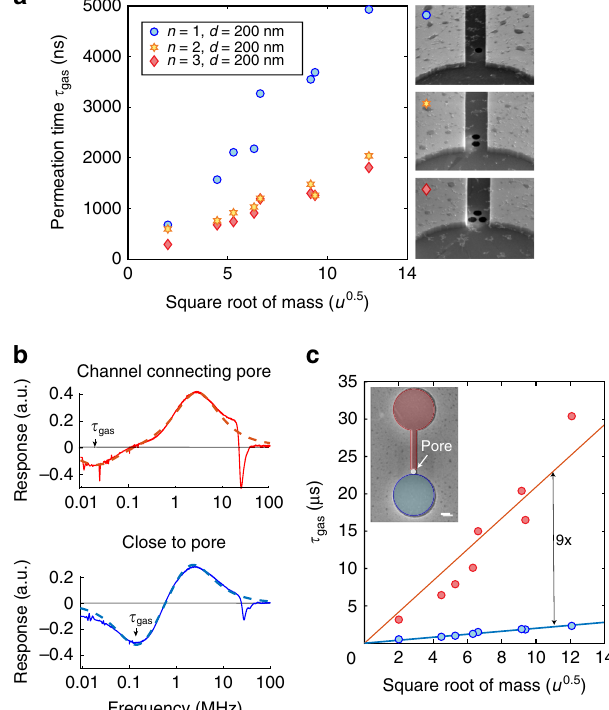
Fig. 4 Tuning of the gas permeation time. a Comparison of measurements between three different drums with increasing number of 200 nm pores. The permeation time τ gas reduces with the cumulative pore area A , but saturates at 3 pores. b Measurements of Im ð z ω Þ with the laser aimed at the drum next to the pore and at the drum connected by a channel to the pore, respectively the blue and the red drum in the SEM inset in c, showing a large tuning of τ gas . c The gas permeation time of the drum close to the perforation is 9 times shorter than of the drum far away from the perforation. Inset: SEM image (false colour) of the two graphene drums connected by a channel with a 400 nm circular pore, scalebar = 1 μ m. All measurements in this fi gure are performed at P = 60 other end of the channel that connects both drums. The SEM inset of Fig. 4c shows a pore inside the channel, that is close to the blue drum, but far from the red drum. The rectangular, graphene- covered channel, with dimensions of 5 × 0.6 × 0.285 μ m 3 , is in series with the pore for the red drum. It is found from Fig. 4c that the permeation time is 9 times longer for the red drum that is in series with the channel. The difference in permeation time is a measure of the transmission probability ψ r for gas atoms to pass through the rectangular channel. In the ballistic regime, the conductance and time-constant are given as the product of the time-constant of the aperture (the pore) and the transmission probability of the channel ψ τ = ψ τ r so that gas,close r × gas,far . The transmission probability